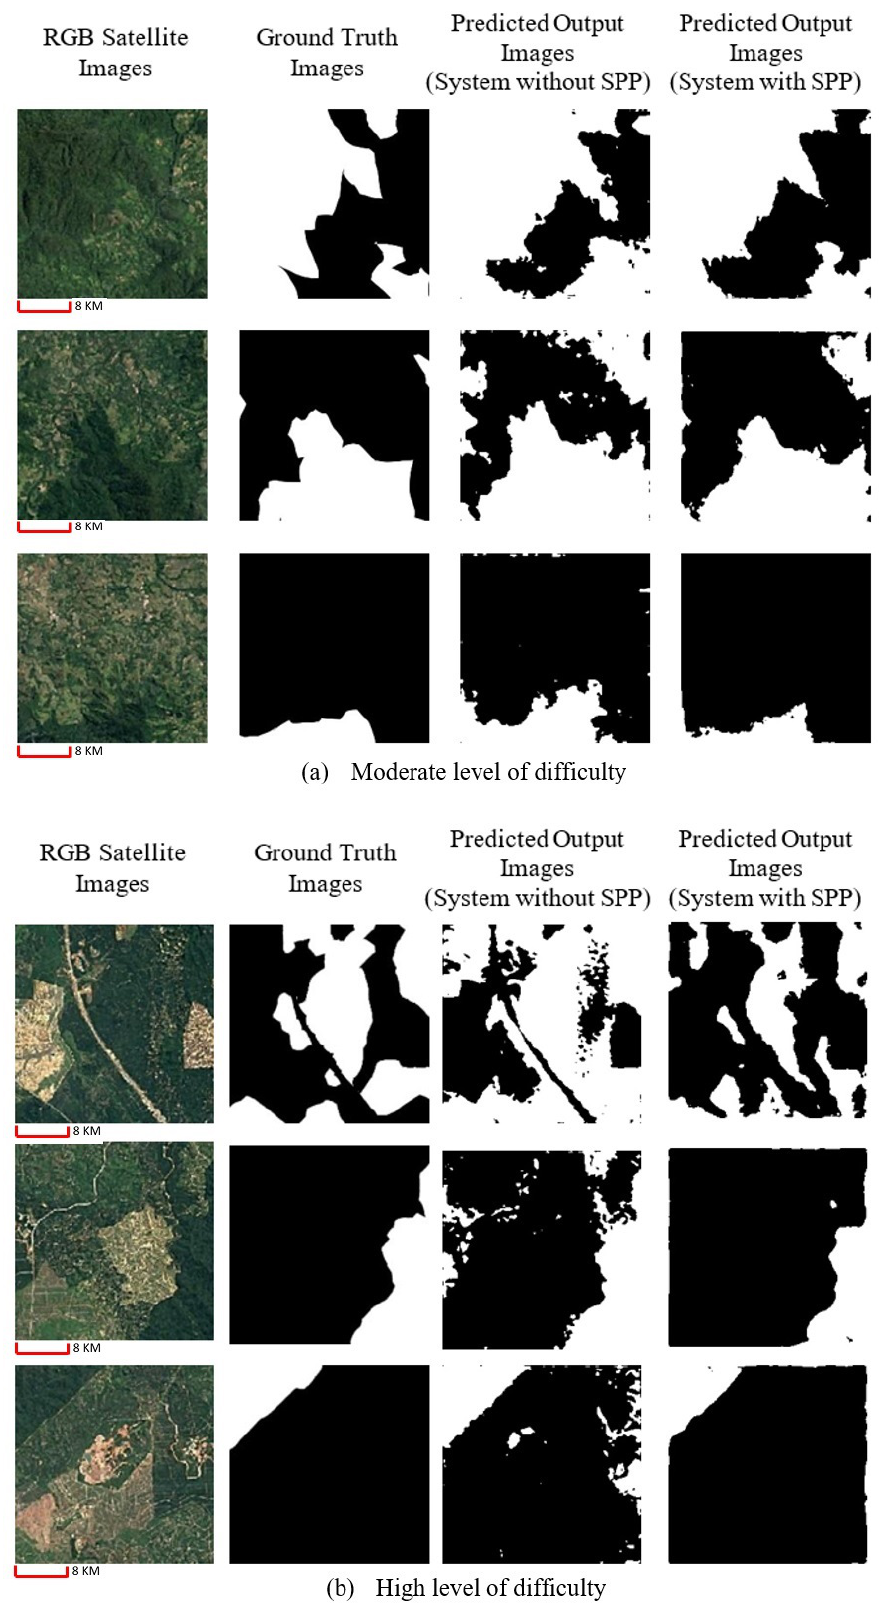
Figure 7. Predicted output images produced by forest monitoring system using dataset of ( a , b